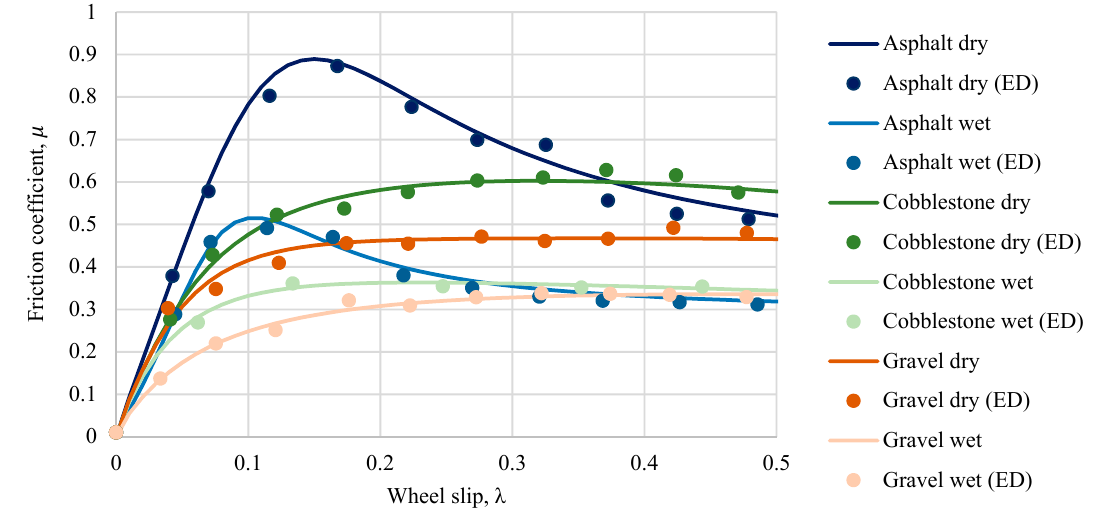
Figure 6. Numerical values of calculated and experimental data (ED) friction coefficients.